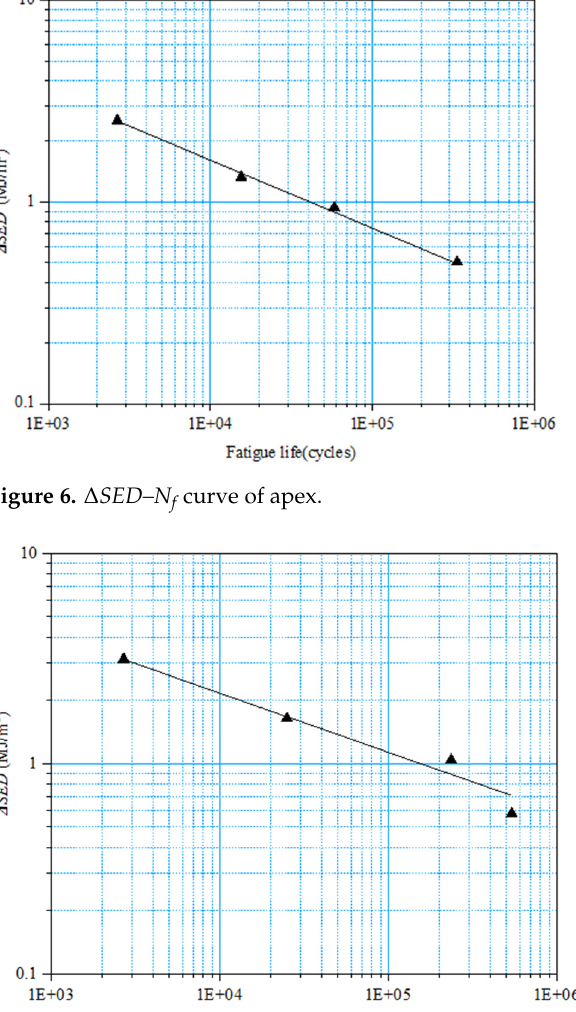
Figure 5. Δ SED–N f curve of carcass.